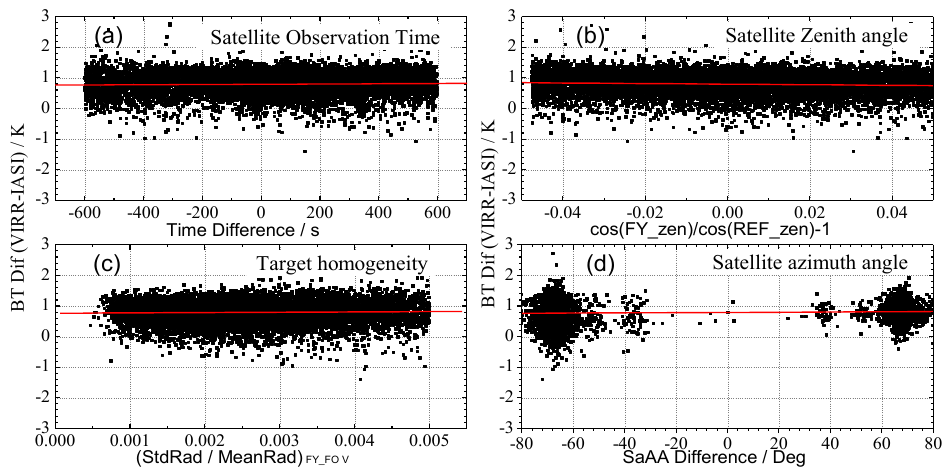
Figure 6. Scatterplots of BT differences between FY-3B/VIRR channel 5 and IASI varying with observation time difference ( a ); satellite zenith angle ( b ); target homogeneity ( c ); and satellite azimuth angle ( d ) based on collocated samples from August to December in 2012 (Solid lines are linear fitting